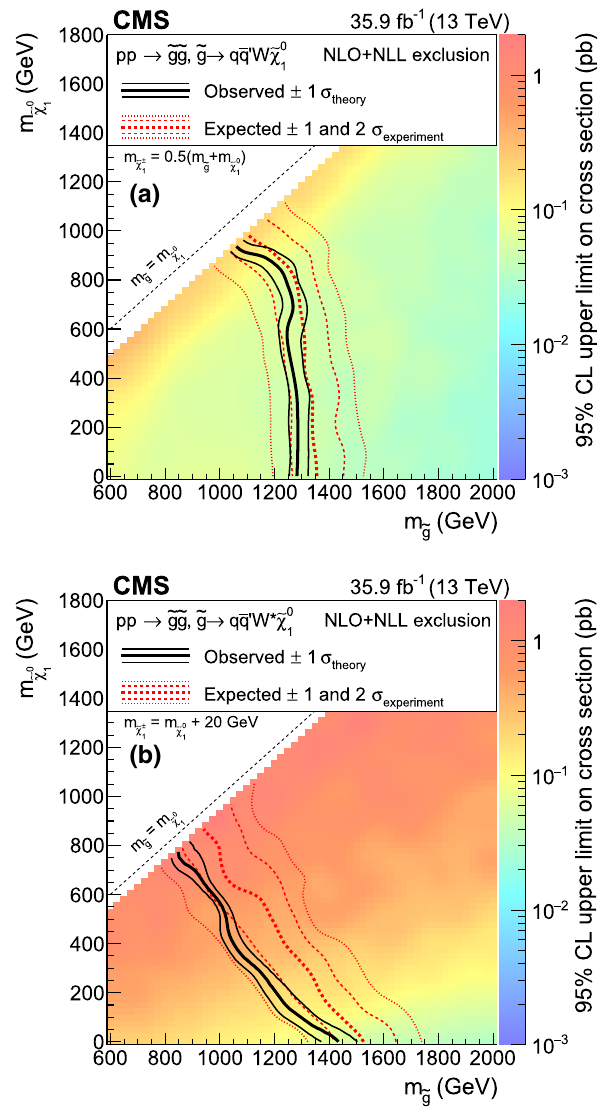
Fig. 6 Exclusion regions at 95% CL in the plane of m (cid:2) χ 0 for the T5qqqqWW model with m (cid:2) χ ± = m + 20GeV ( b ). The notations are as in Fig. 5 m (cid:2) χ ± (cid:2) χ 0 1 1